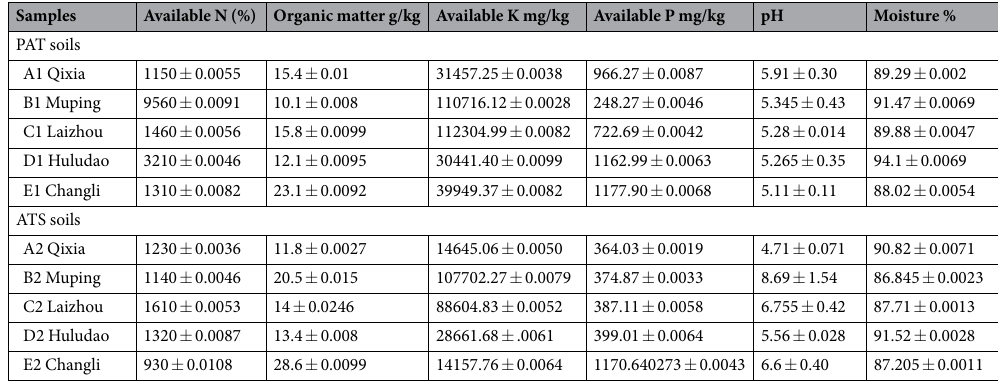
Table 1. Physicochemical parameters of the soil